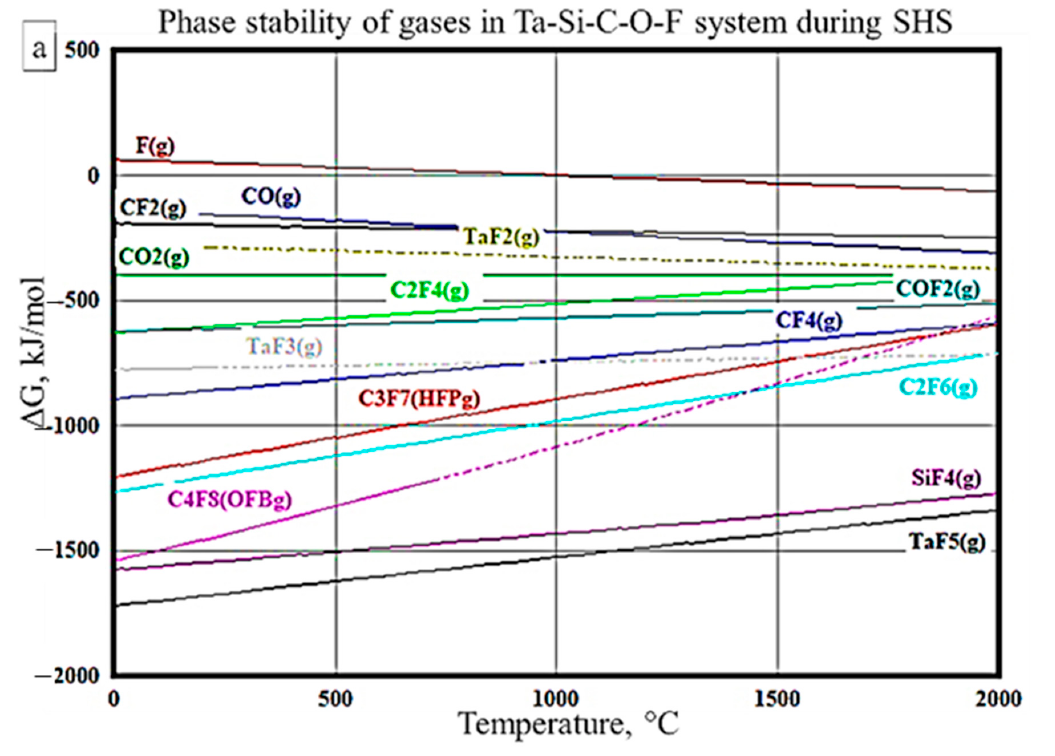
Figure 4. Ellingham diagrams of phase stability for selected gaseous species in the Ta-Si-C-O-F system ( a ) and sintering of TaSiC-nw composition ( b ). Solid lines correspond to experimentally measured values, dotted lines to projections.